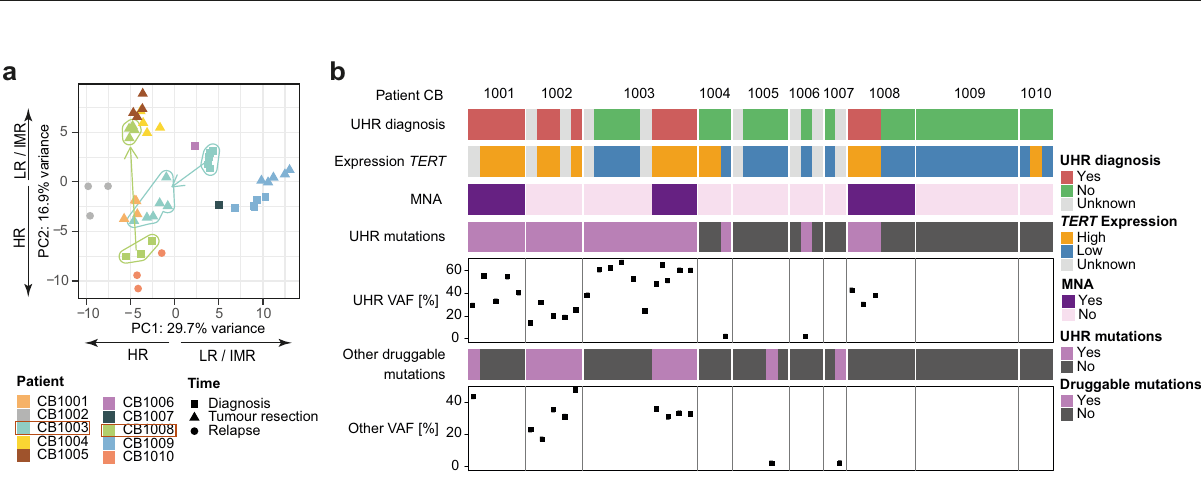
Fig. 4 Primary and metastatic tumour evolution inferred by genetic analysis of clonality. a Single-nucleotide variant- (SNV)-based phylogenetic trees depict variable clonal diversi fi cation. Branch lengths correspond to the total numbers of SNVs. Branch colours represent different subclones. Numbers at the end of each branch indicate samples containing all clones (numbers in circles) of the branch and its ancestor clones. Samples were collected at diagnosis (orange), at tumour resection (red) and at diagnosis of relapse (turquoise). Metastatic samples are indicated by asterisks. A deeper data showcase is provided for patient CB1001, showing SNV- ( b ) and somatic copy-number alteration- (SCNA)-based trees (c). d SCNA plots from sample 15 (rainbow) showing a loss of heterozygosity (LOH) event on chromosome 6q that is absent in the metastastic sample 11 (green). e SCNA plots from the metastatic sample 11 (green shaded) and primary tumour sample 15 (rainbow) showing an mirrored subclonal allelic imbalances (MSAI) event on chromosome 9. SNV tree (f) compared to SCNA phylogeny (g) in CB1003. Time point or spatial position is indicated by shading, none (metastasis), grey (biopsy at diagnosis) and green (tumour resection). h Dynamic acquisition of additional copies of the MYCN locus on chromosome 2p. i Monoallelic gain on chromosome 9q in the tumour resection samples. (green) but not in the metastatic clone.